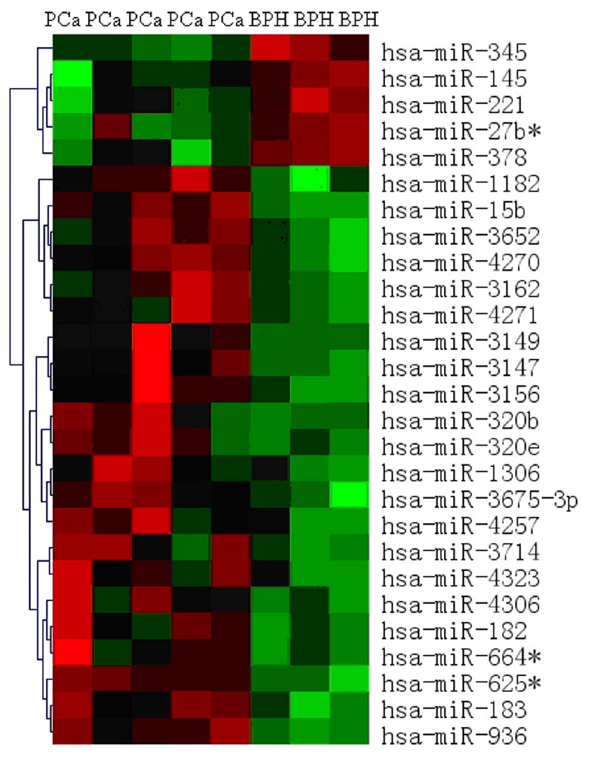
Figure 1. Significantly different expressed miRNAs between PCa and BPH by miRNA microarray analysis. In PCa tissues, five miRNAs were down-regulated and twenty-two miRNAs were up- regulated. miRNA-182 was up-regulated with fold change of 3.07 and further confirmed by real-time RT-PCR with fold change of 2.85.